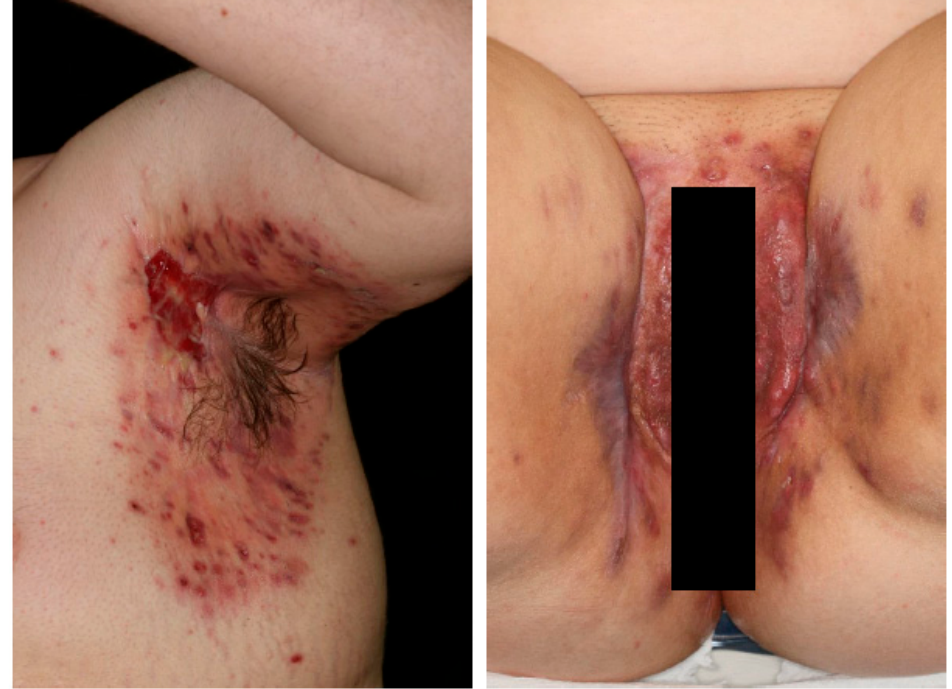
Figure 1. The clinical features of Hidradenitis suppurativa (HS). Erythema, erosions, pustules and scarring in the axilla of a male patient. Similar features in the perineal area in a female patient.